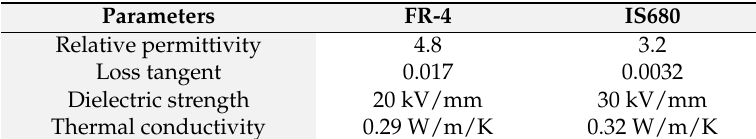
Table 3. Comparison of material properties of FR-4 and IS680.